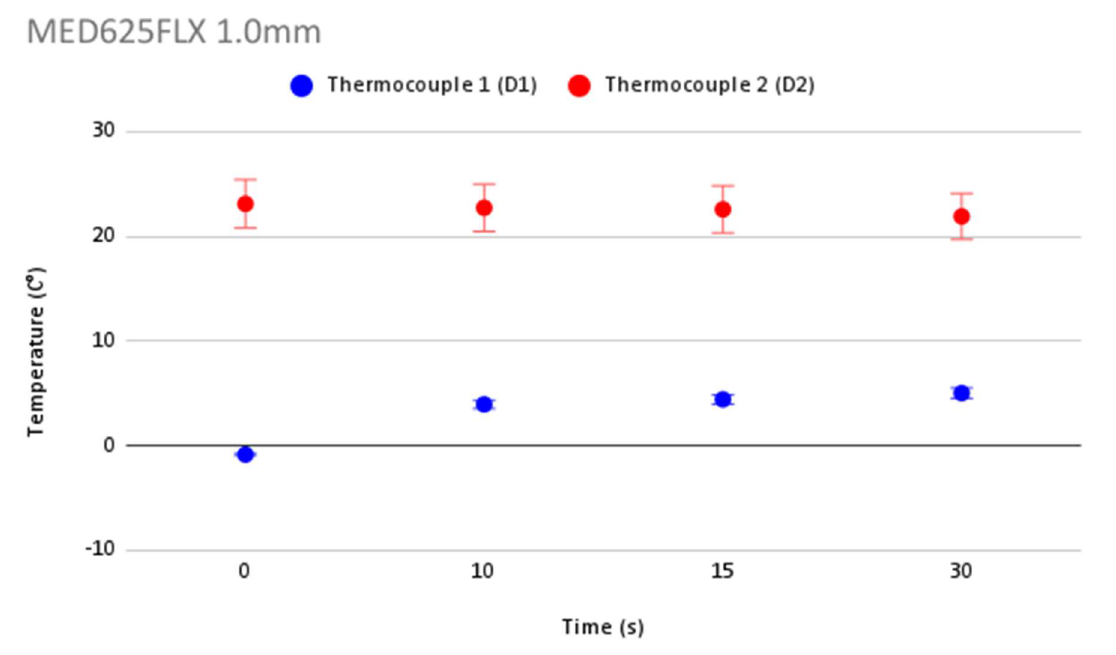
Figure 8. Repeatability of temperature measurements and error bars for MED625FLX of 1.0 mm.